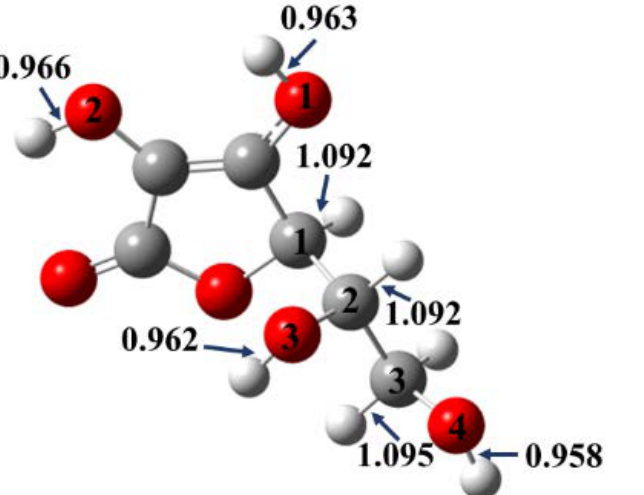
Figure 4. Optimized geometry of the studied natural antioxidant additive, L-ascorbic acid (Asc). Geometry optimizations have been carried out at the M06-2X/6-311++G(2d,2p) level of theory in gas phase, and the corresponding bond lengths are also shown in Å.